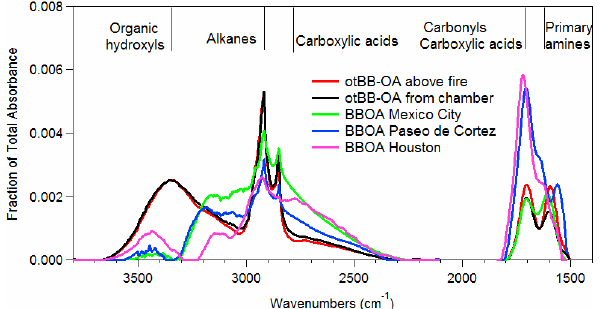
Figure 1. Normalized FTIR spectra for experiment 2 for the sample taken directly from the olive tree branches fire (red line) and from the chamber the first hour of the experiment (black line). The 2 mass spectra are similar to each other. The otBB-OA spectrum differs a lot from other BBOA FTIR spectra measured in Mexico City, Paseo de Cortez and Houston (Liu et al., 2009; Russell et al., 2009). The correlation coefficients are R 2 =0.34, 0.29 and 0.21 correspondingly.